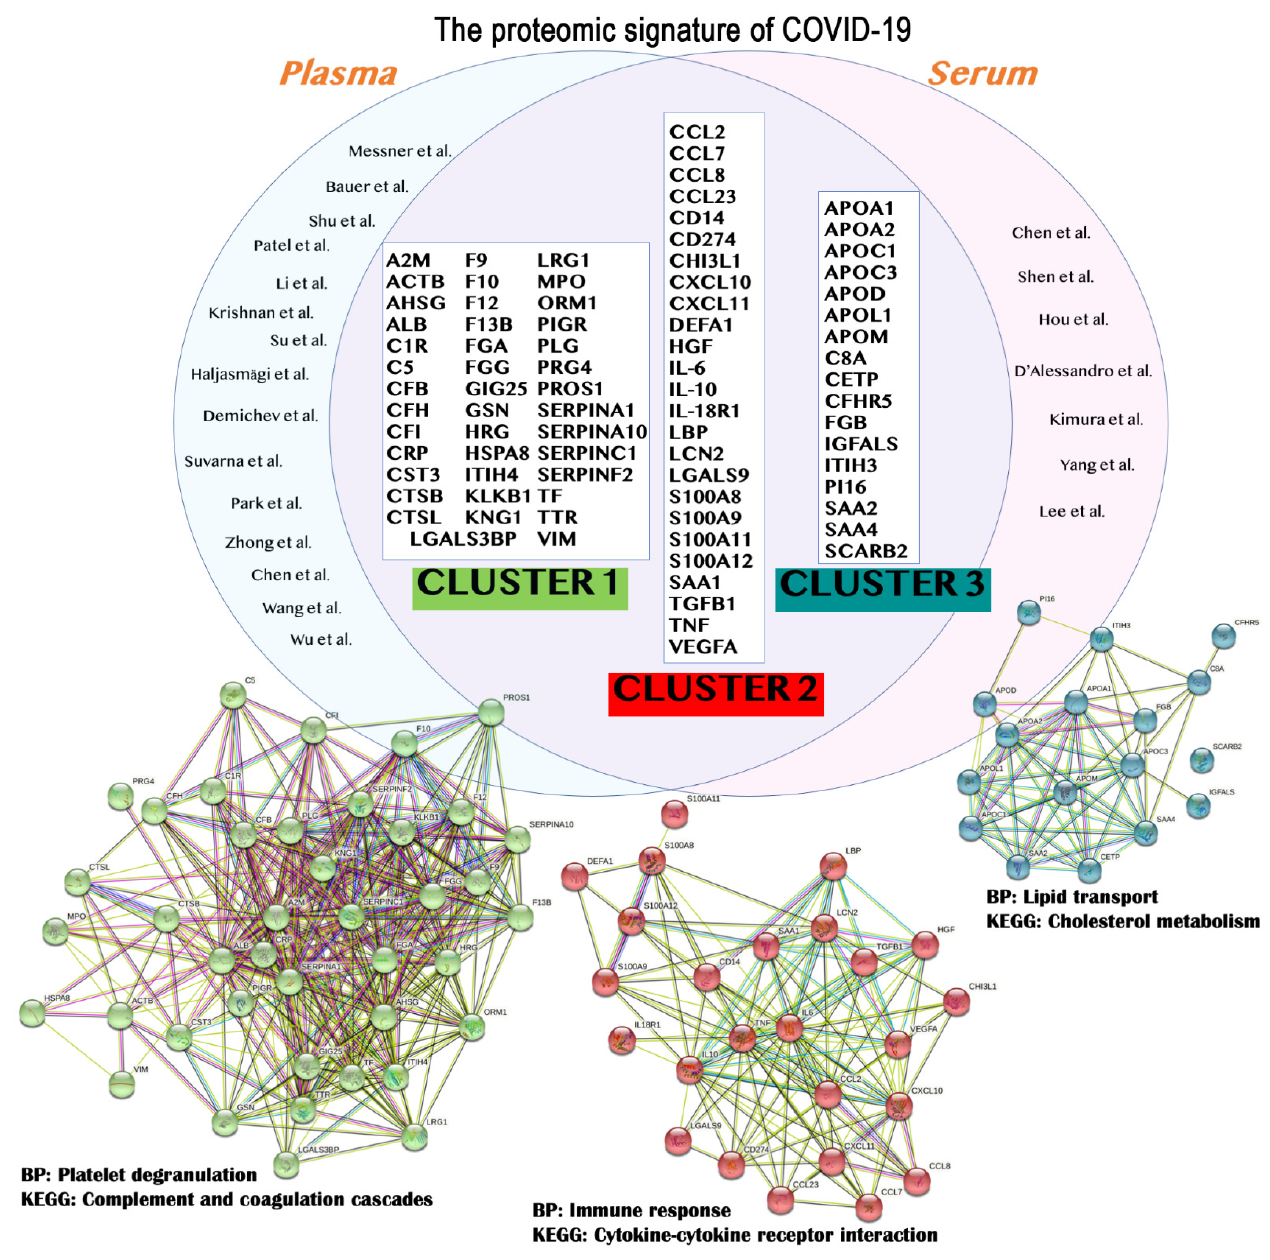
Figure 2. The main findings obtained from the review of proteomics studies are summarized. In particular, the results from plasma [34–36,38–42,73–79] and serum [43–47,83,86] studies were merged to identify the common proteins (top) that should represent the proteome signature of COVID-19. These protein entries were analyzed and clustered using STRING version 11.5, revealing the formation of three main clusters (bottom). The relative biological processes (BP) and Kyoto Encyclopedia of Genes and Genomes (KEGG) pathways were indicated. A detailed list for the proteins depicted in this figure is available in Table 4. Table 4. The list of the proteins identified in more than one study characterizing the blood prote ‐ omic signature of COVID ‐ 19.